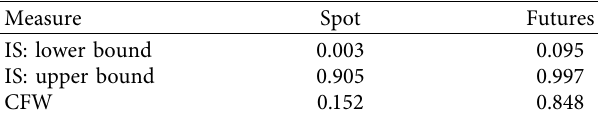
Table 6: Estimates of the vector error correction model. Table 7: Price discovery measures